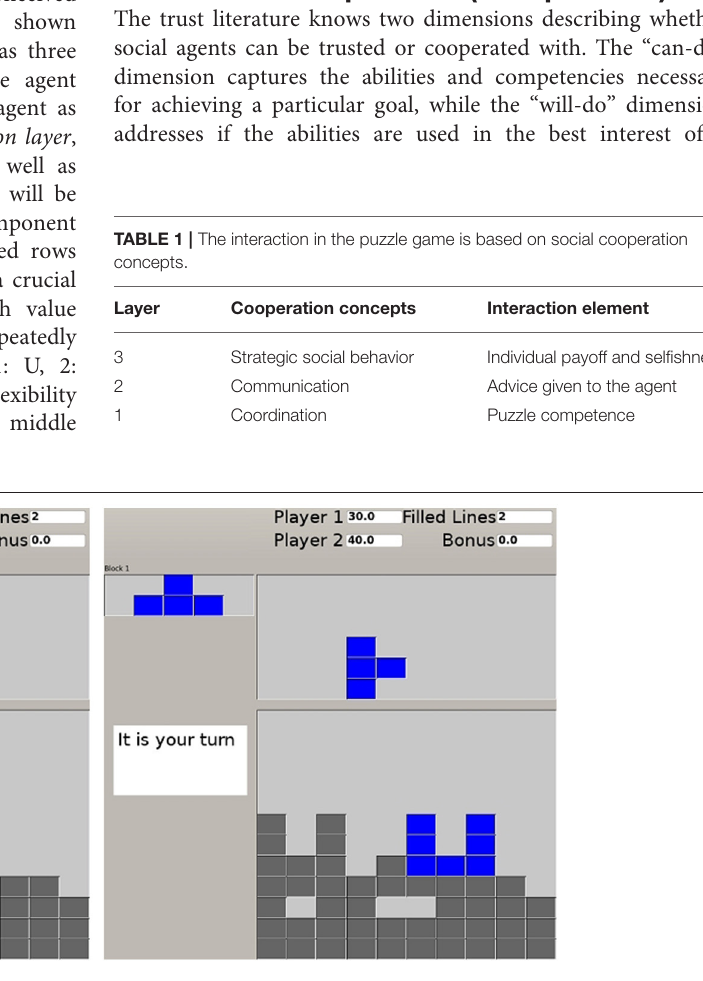
FIGURE 1 | User interface of the cooperative game. The top area is for human players to manipulate the block, the bottom area is the puzzle field. Left: the human player has recommended the U-block. Right: the agent has accepted and placed the block, leaving the T-block for the human player.